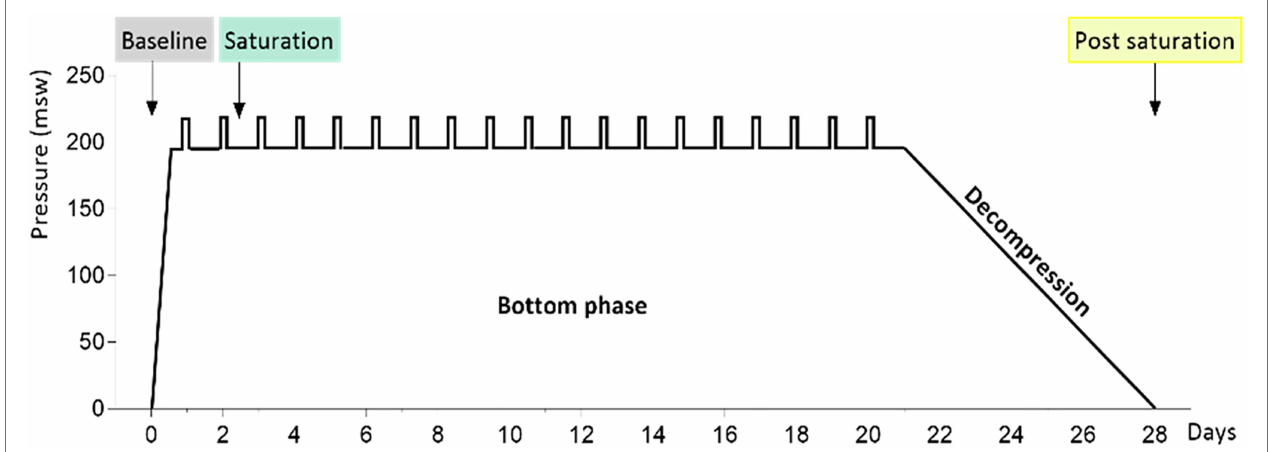
FIGURE 1 | The 4-week hyperbaric saturation profile. Pressure is shown as meters of sea water (msw). The saturation was done in a heliox atmosphere, with 6-h compression, app. 21-day bottom phase at or near 200 msw, and app. 8-day decompression. Daily bell runs are indicated by vertical bars on the bottom phase profile. Colored labels point to saliva collection times before, during, and after the